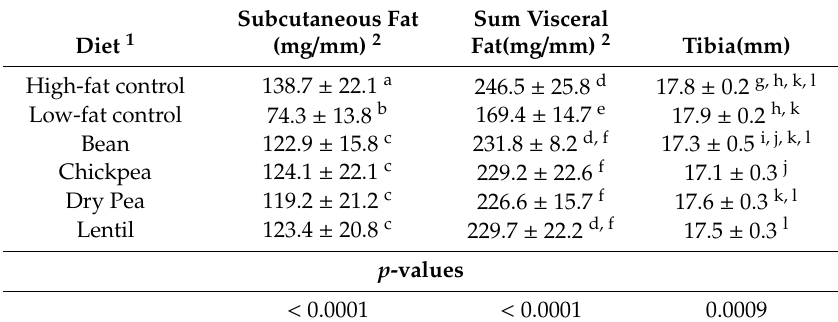
Table 2. E ff ect of pulses on